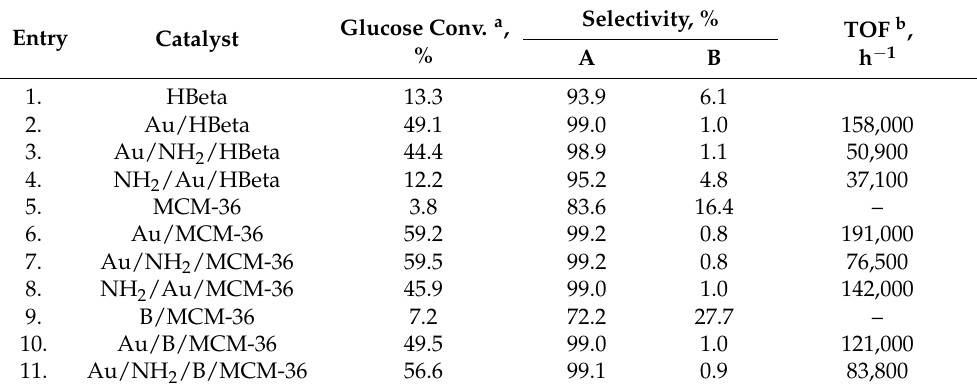
Table 5. Results of microwave-assisted oxidation of glucose with hydrogen peroxide over selected catalysts.